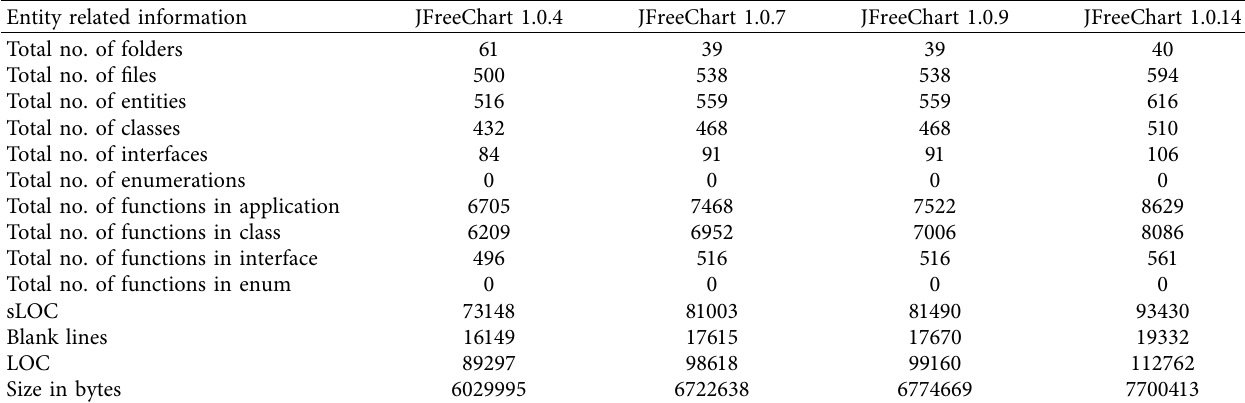
Table 2: Facts about entities in JFreeChart dataset.